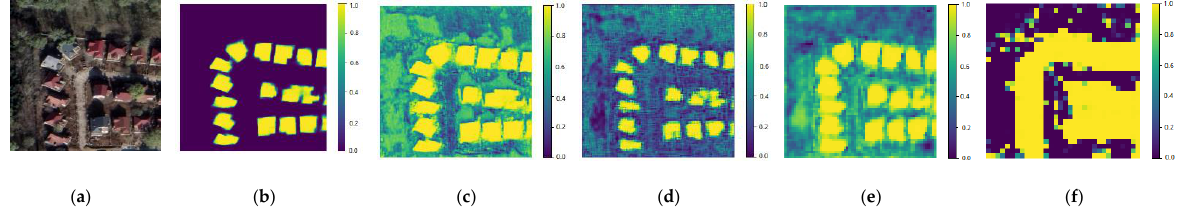
Figure 9. Feature map visualization. ( a ) Sample image. ( b ) Depth = 1. ( c ) Depth = 2. ( d ) Depth = 3. ( e ) Depth = 4. ( f ) Depth = 5.